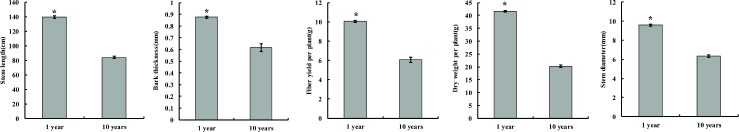
Changes in ramie fiber yield and stem traits in response to continuous cropping.Note: The error bars represent the standard error, and * represent significance at P < 0.05.